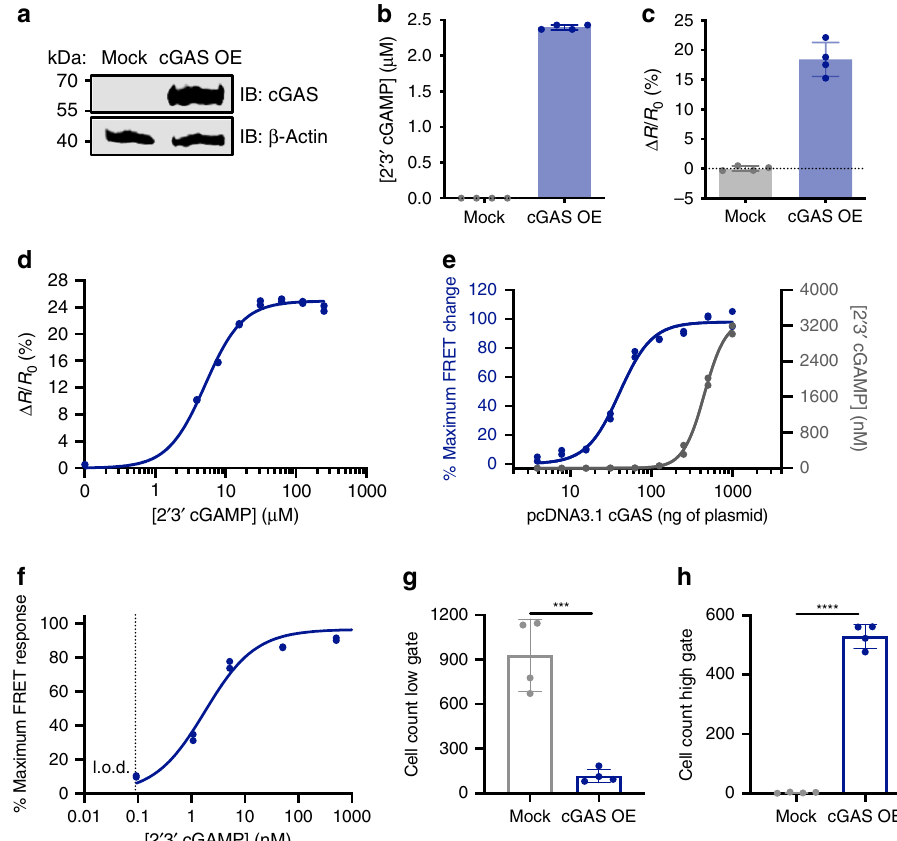
Fig. 3 BioSTING quantitates cGAMP in single cells in a manner compatible with fl ow screening. HEK293T cells stably expressing BioSTING transfected with 1 µ g of either empty pCDNA3.1 vector or pCDNA3.1-cGAS vector and analyzed for a cGAS expression by western blot (data are representative of